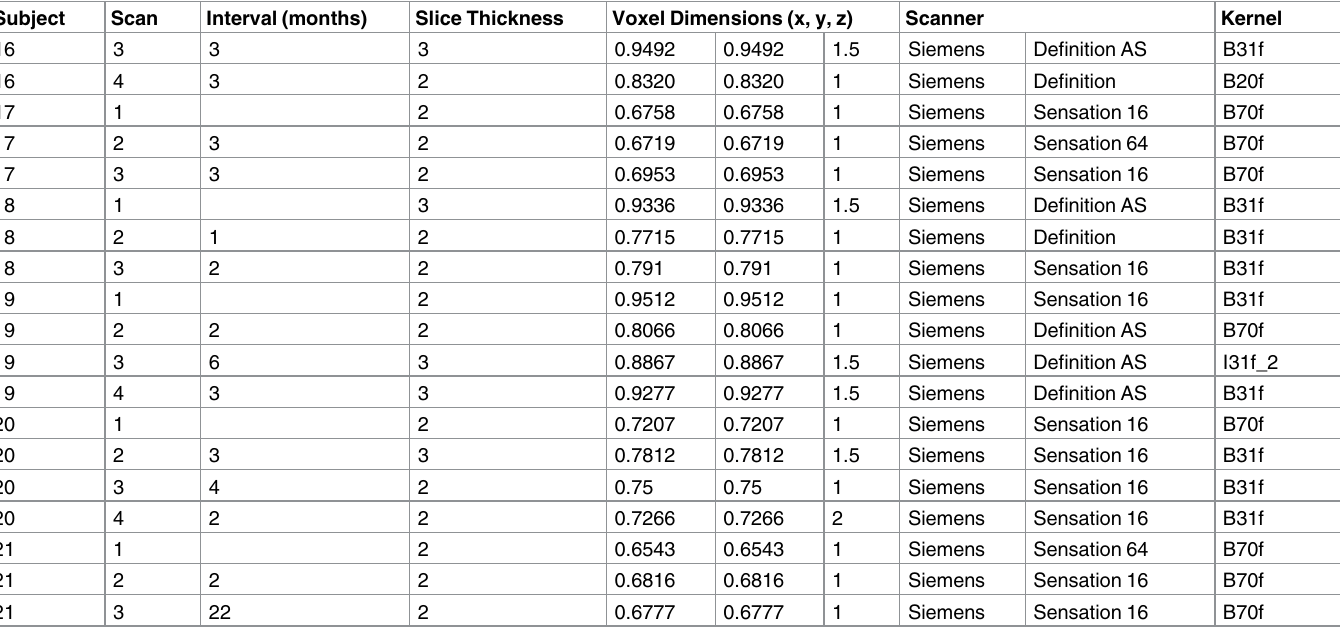
PLOS ONE | https://doi.org/10.1371/journal.pone.0179812 July 27,